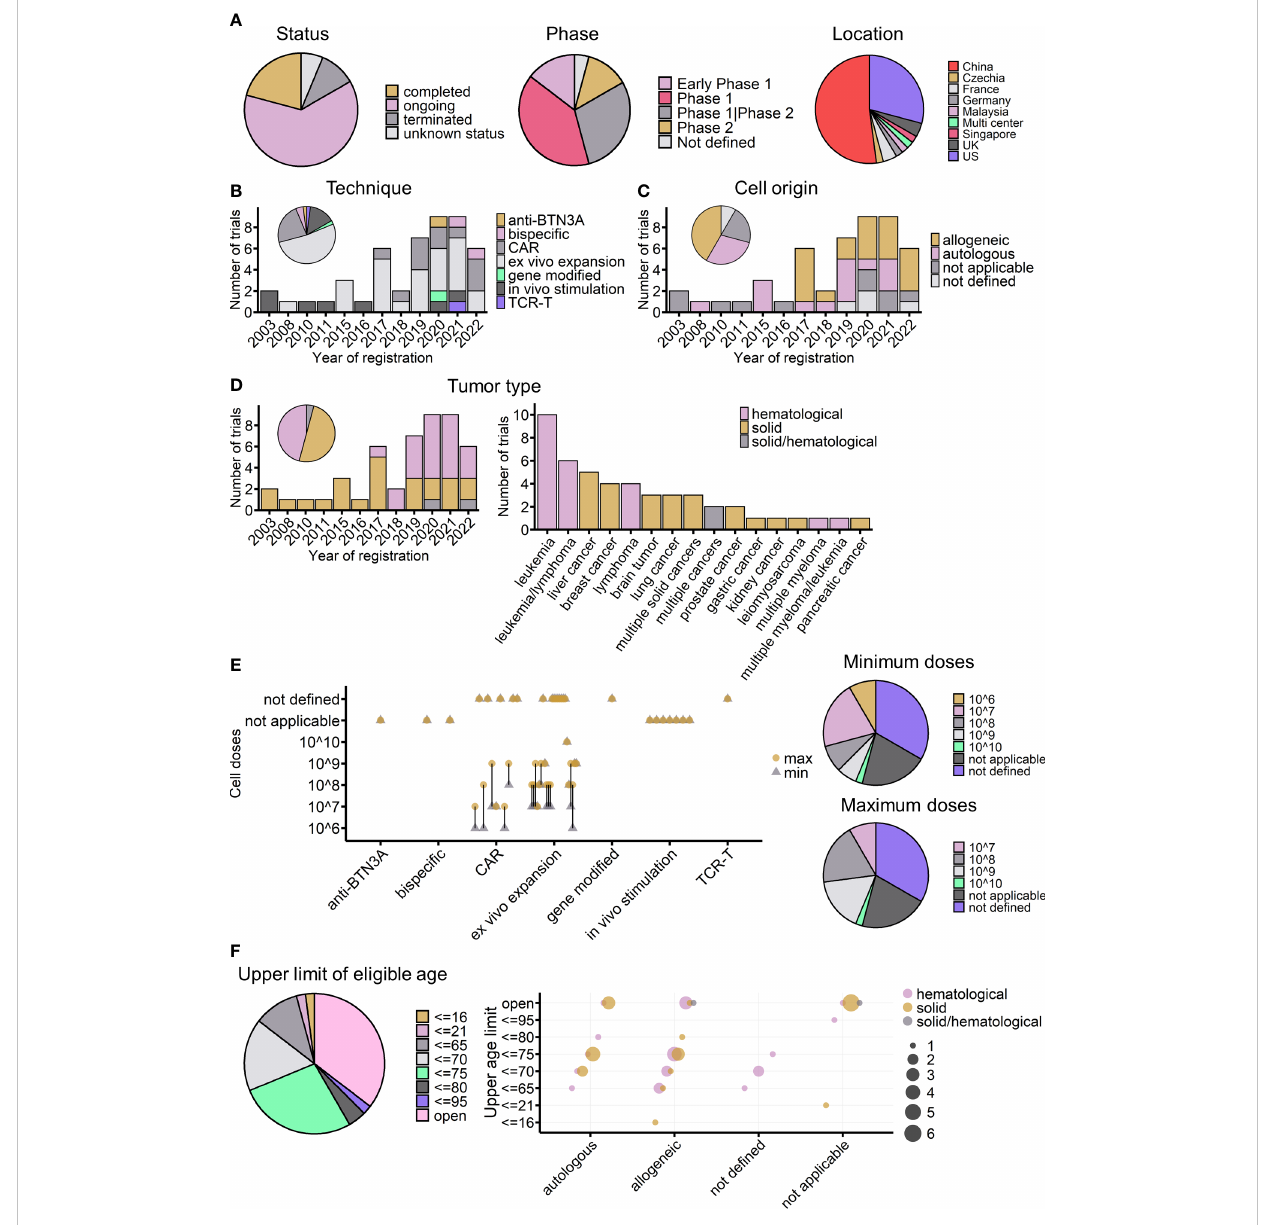
FIGURE 6 Overview of currently registered gd T-cell immunotherapy clinical trials ( n = 48). (A) Proportions of currently registered gd T-cell immunotherapy clinical trials according to status, phase, and location. (B) Timeline of registered clinical trials by treatment strategy. The pie chart shows the proportion of trials for each strategy. (C) Timeline of registered clinical trials by infusion cell origin. (D) Timeline of registered clinical trials by tumor type (left) and detailed malignancies involved in registered trials (right). The pie chart indicates the proportions of different tumor types across all registered trials. (E) Planned infusion dosage of registered trials. Left: treatment strategies are indicated on the x -axis, and planned gd T-cell infusion cell numbers are indicated on the y -axis. The round yellow dot shows the planned maximum infusion dose, and the gray triangle dot shows the planned minimum infusion dose. The bar connects the maximum and minimum number for each trial. Right: the proportions of different planned minimum (upper) and maximum (lower) infusion doses. (F) Upper age limit of registered gd T-cell immunotherapy clinical trials. Left: proportions of different upper age limits. Right: the relationship between upper age limits, treatment strategy usages, and tumor types. The bubble color shows the tumor type of the trial, and the bubble size indicates the number of trials. (C – F) Not applicable: strategies not involving cell infusion; not de fi ned: infusion cell origin not de fi